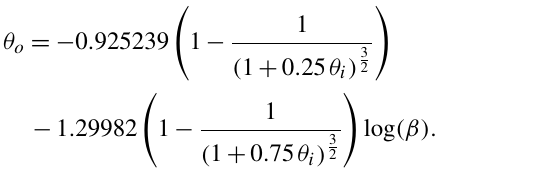
Figure 8. The relationship between the albedo values correspond- ing to the solar zenith angle value of 73 ◦ measured operationally at Sodankylä and the regression (albedo = 0.84–0.29 b − 0 . 008 k 0 ) based on measured surface roughness parameters b (Eq. 1) and k 0 (Eq. 2) at the NorSEN mast in March and April 2009. The darkness of the markers is related to the fraction of diffuse